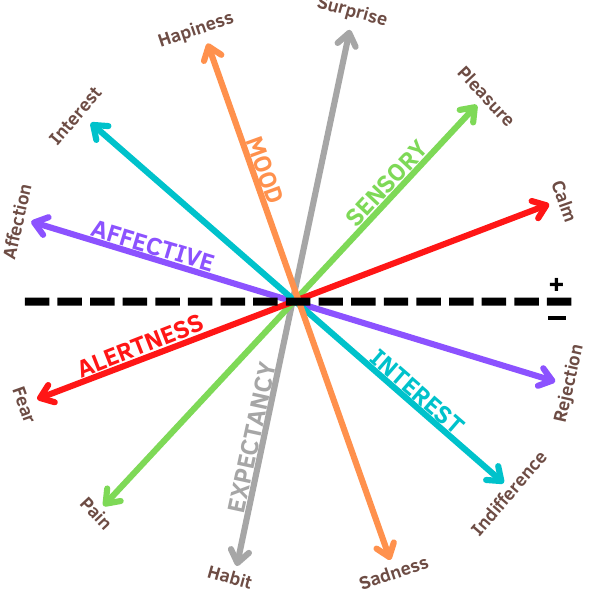
Figure 4. Representation of the emotions for the dimensional emotional model, proposed based on Plutchik’s wheel of emotions [63] .